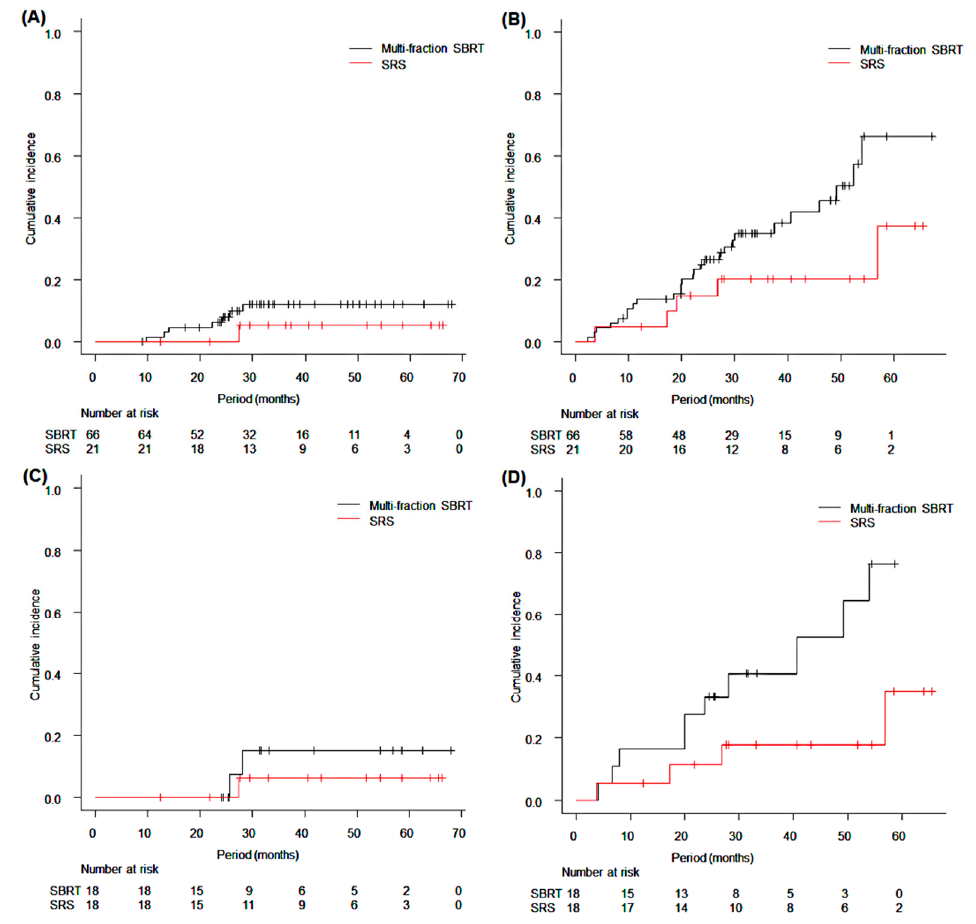
Figure 3. ( A ) Curves of cumulative incidences of local recurrence after stereotactic radiosurgery (SRS) and after multi-fraction stereotactic body radiotherapy (SBRT) before propensity score matching. ( B ) Curves of cumulative incidences of percentage of patients who received systemic therapy or best supportive/palliative care (SST-BSC) after SRS and after multi-fraction SBRT before propensity score matching. ( C ) Curves of cumulative incidences of local recurrence after SRS and after multi-fraction SBRT after propensity score matching. ( D ) Curves of cumulative incidence of SST-BSC rate after SRS and after multi-fraction SBRT after propensity score matching.